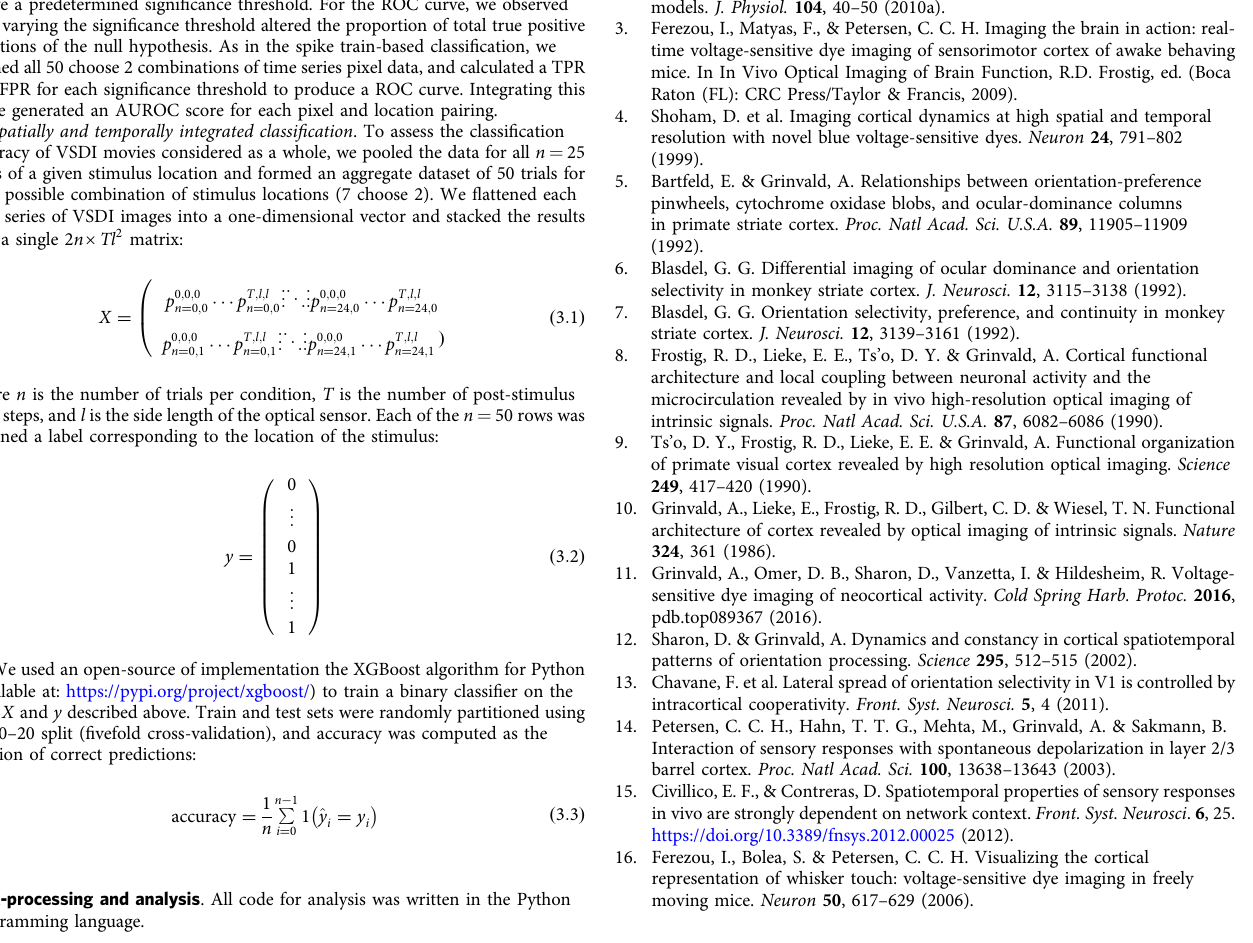
We used an open-source of implementation the XGBoost algorithm for Python (available at: https://pypi.org/project/xgboost/) to train a binary classi fi er on the data X and y described above. Train and test sets were randomly partitioned using an 80 – 20 split ( fi vefold cross-validation), and accuracy was computed as the fraction of correct predictions: